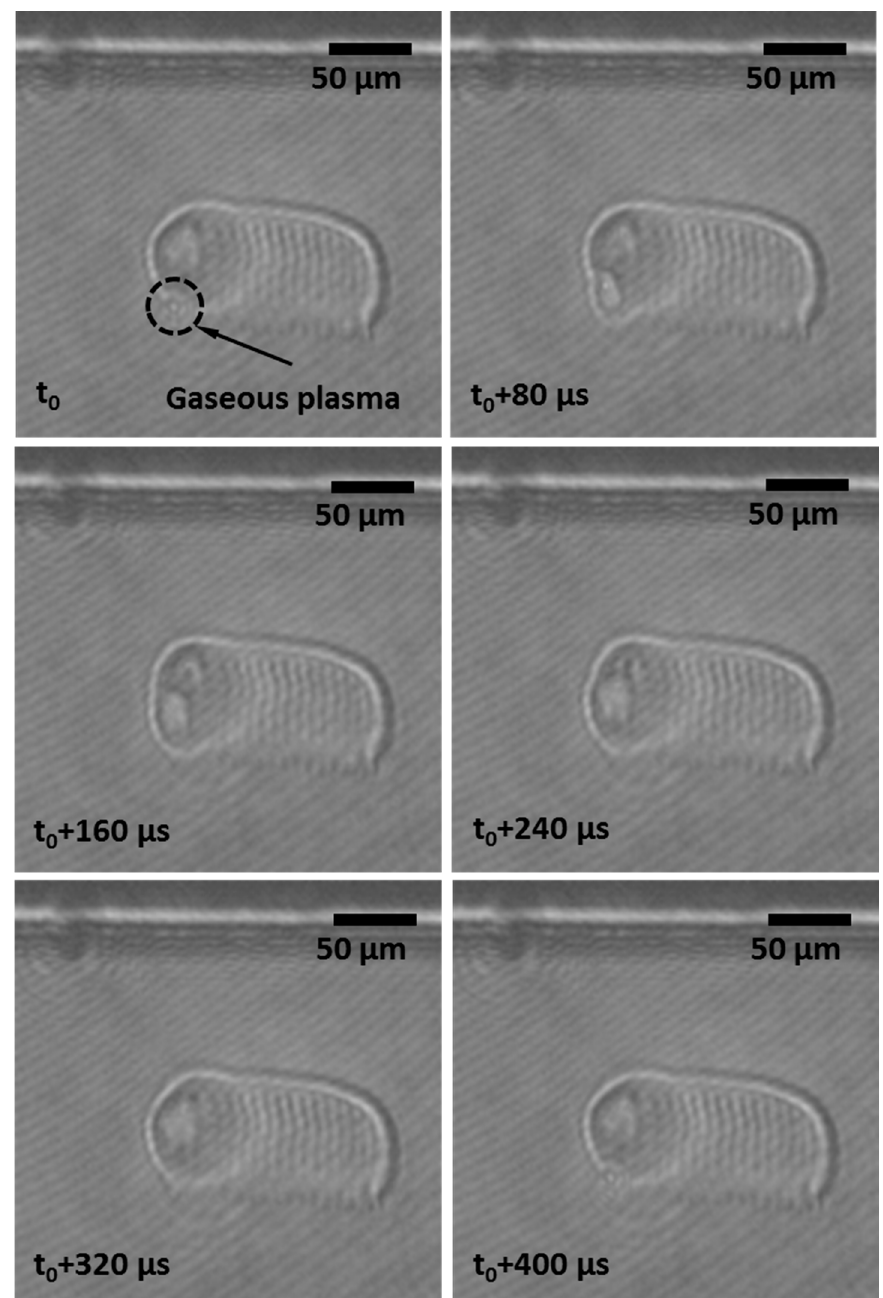
Figure 3. Micromachines 2015 , 6 015, 6, page–page